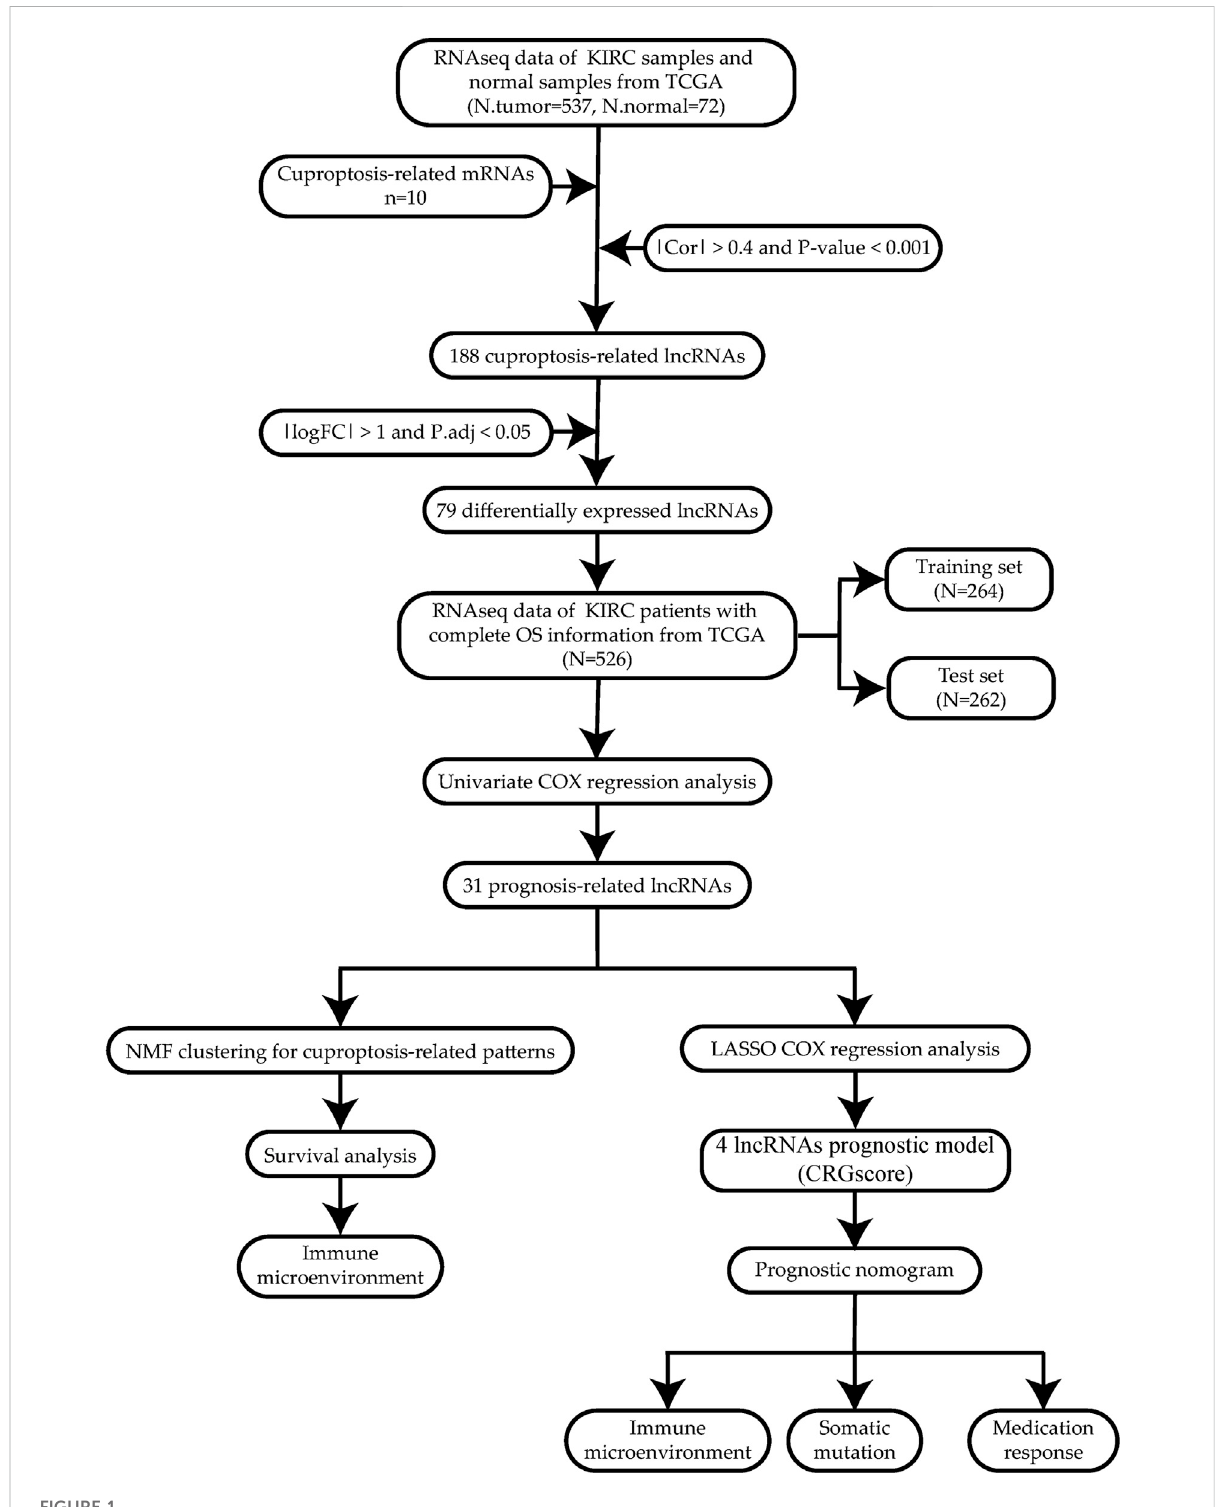
FIGURE 1 Research fl ow